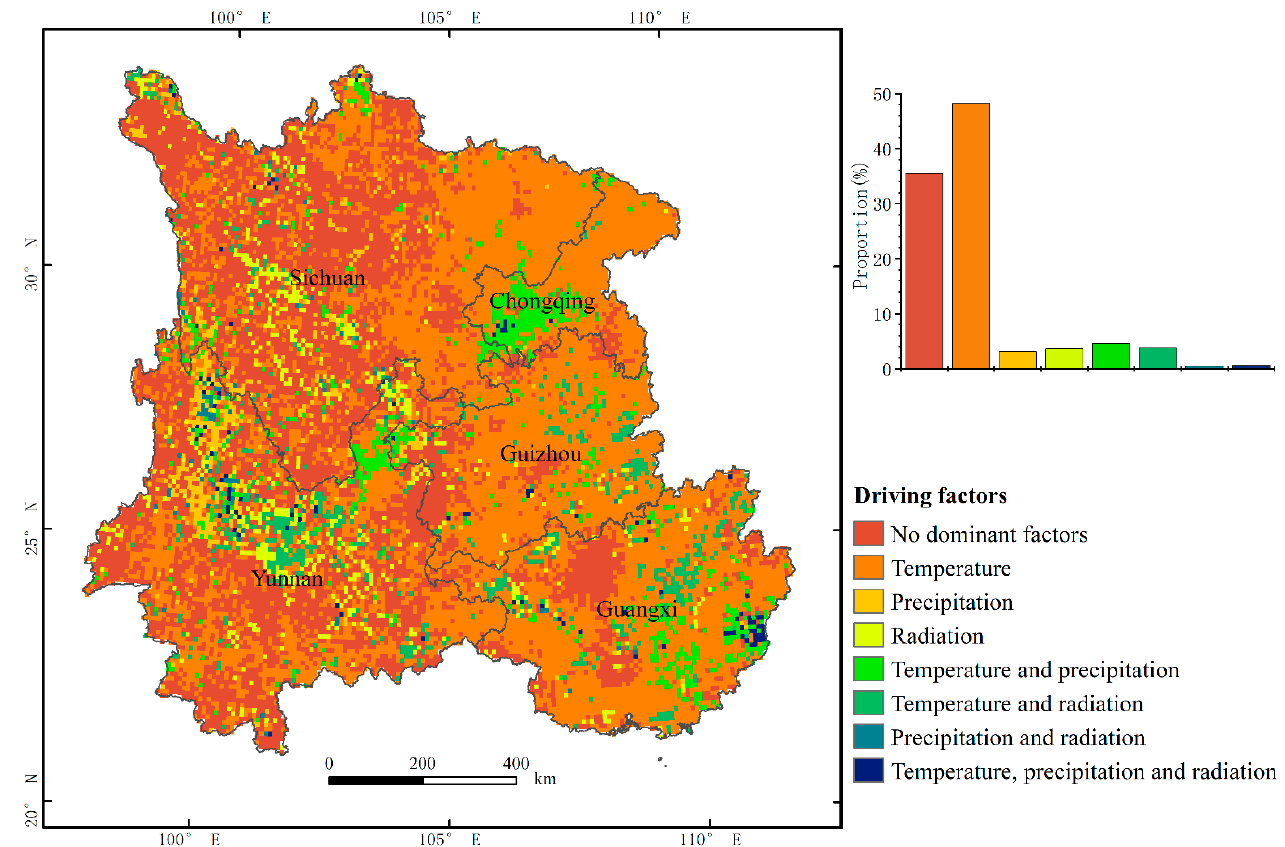
Figure 9. Spatial distribution of the dominant environmental factors over Southwest China during 1982–2015.